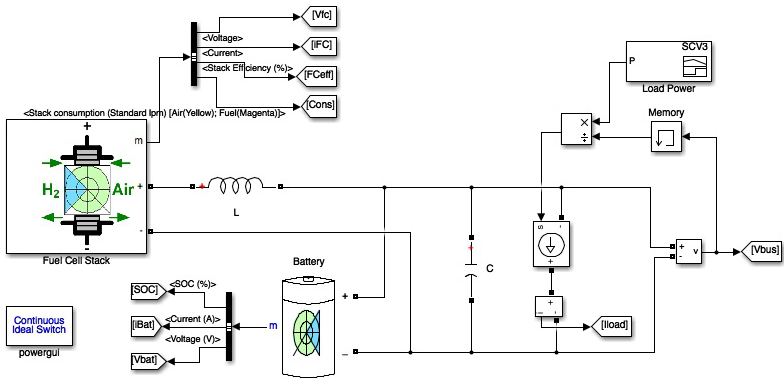
Figure 12. Passive hybrid powertrain simulation